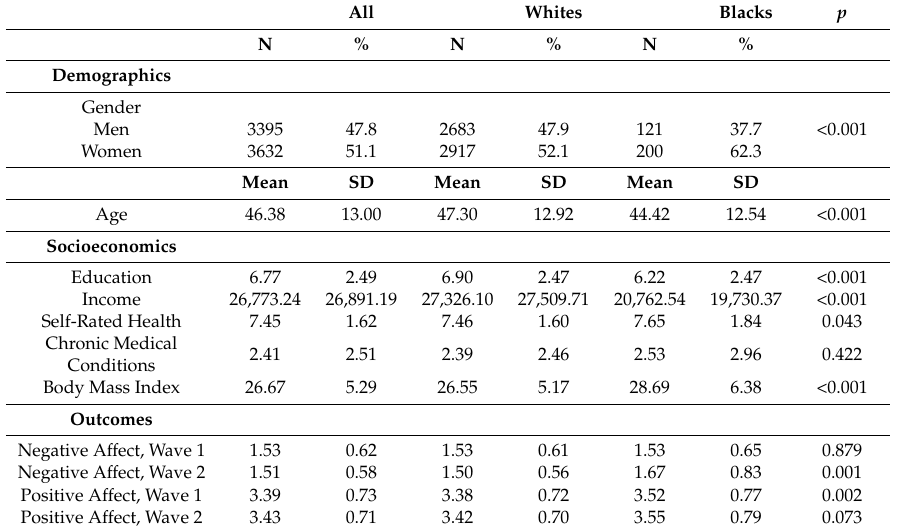
Table 1. Descriptive statistics in the pooled sample and based on race. All